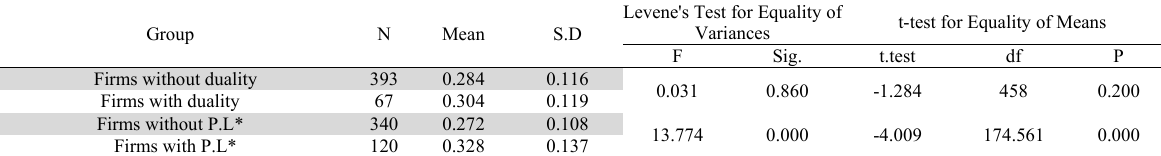
Independent Samples T-Test Group N Mean S.D